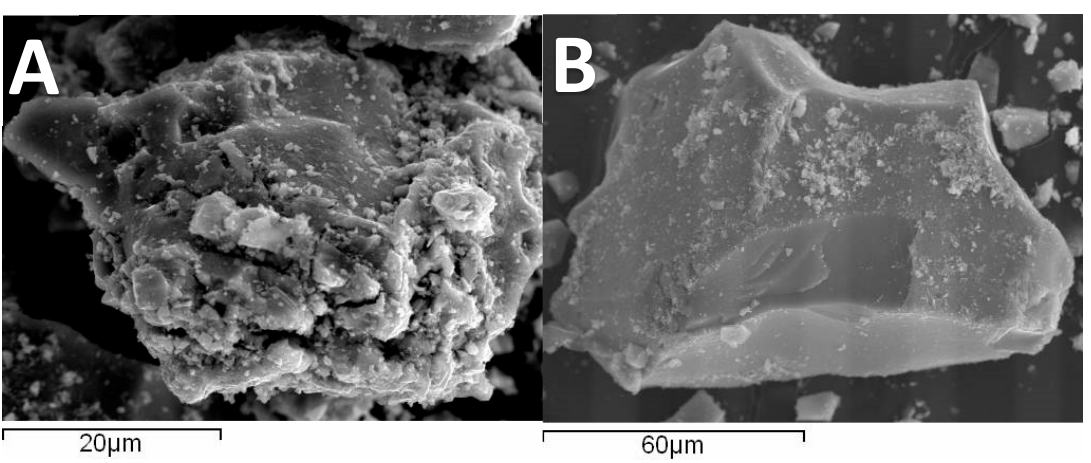
Figure 2. Representative scanning electron microscopy (SEM) images of ( A ) Ti-Nb 2 O 5 and ( B ) W-Nb 2 O 3 . Table 1. Dopant loading on the niobia based supports by Energy-Dispersive X-ray Spectroscopy. Support Dopant